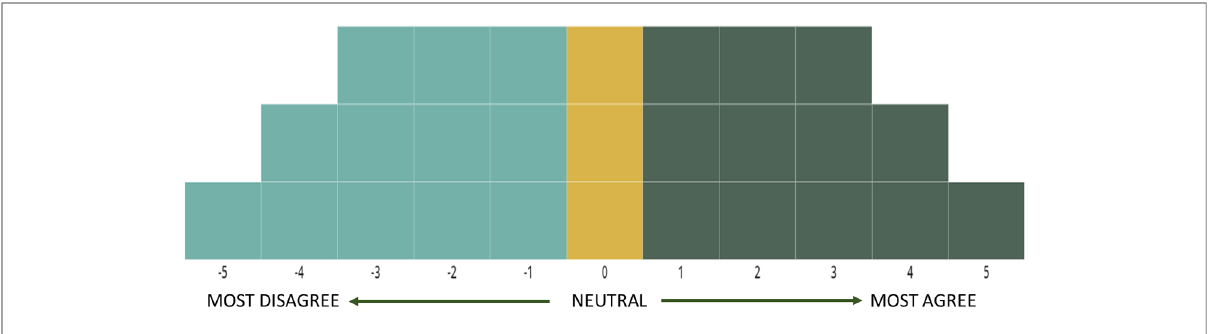
FIGURE 1 Q-sorting grid used in the present research. The wide pyramid base was constructed to reduce the number of neutral classi fi